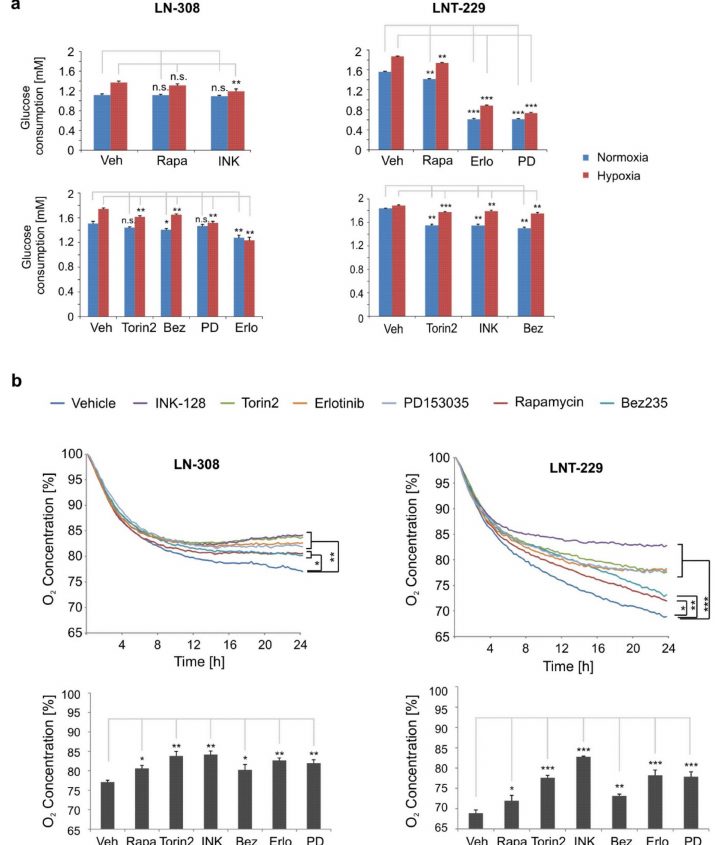
Figure 3. mTOR inhibition attenuates glucose and oxygen consumption. ( a ) LNT-229 and LN-308 cells were cultured in medium containing 2 mM glucose and treated with rapamycin (100 nM), torin2 (100 nM), INK-128 (100 nM), NVP-Bez235 (10 nM), erlotinib (10 µ M) or PD153035 (10 µ M) in hypoxia (0.1% oxygen) for 8 h. Glucose consumption was measured via quantification of remaining glucose in the supernatant ( n = 3, mean ± S.D., * p < 0.05, ** p < 0.01, *** p < 0.001, n.s. = not significant). ( b ) LNT-229 and LN-308 cells were exposed to serum-free medium with 25 mM glucose and treated with rapamycin (100 nM), torin2 (100 nM), INK-128 (100 nM), NVP-Bez235 (10 nM), erlotinib (10 µ M) or PD153035